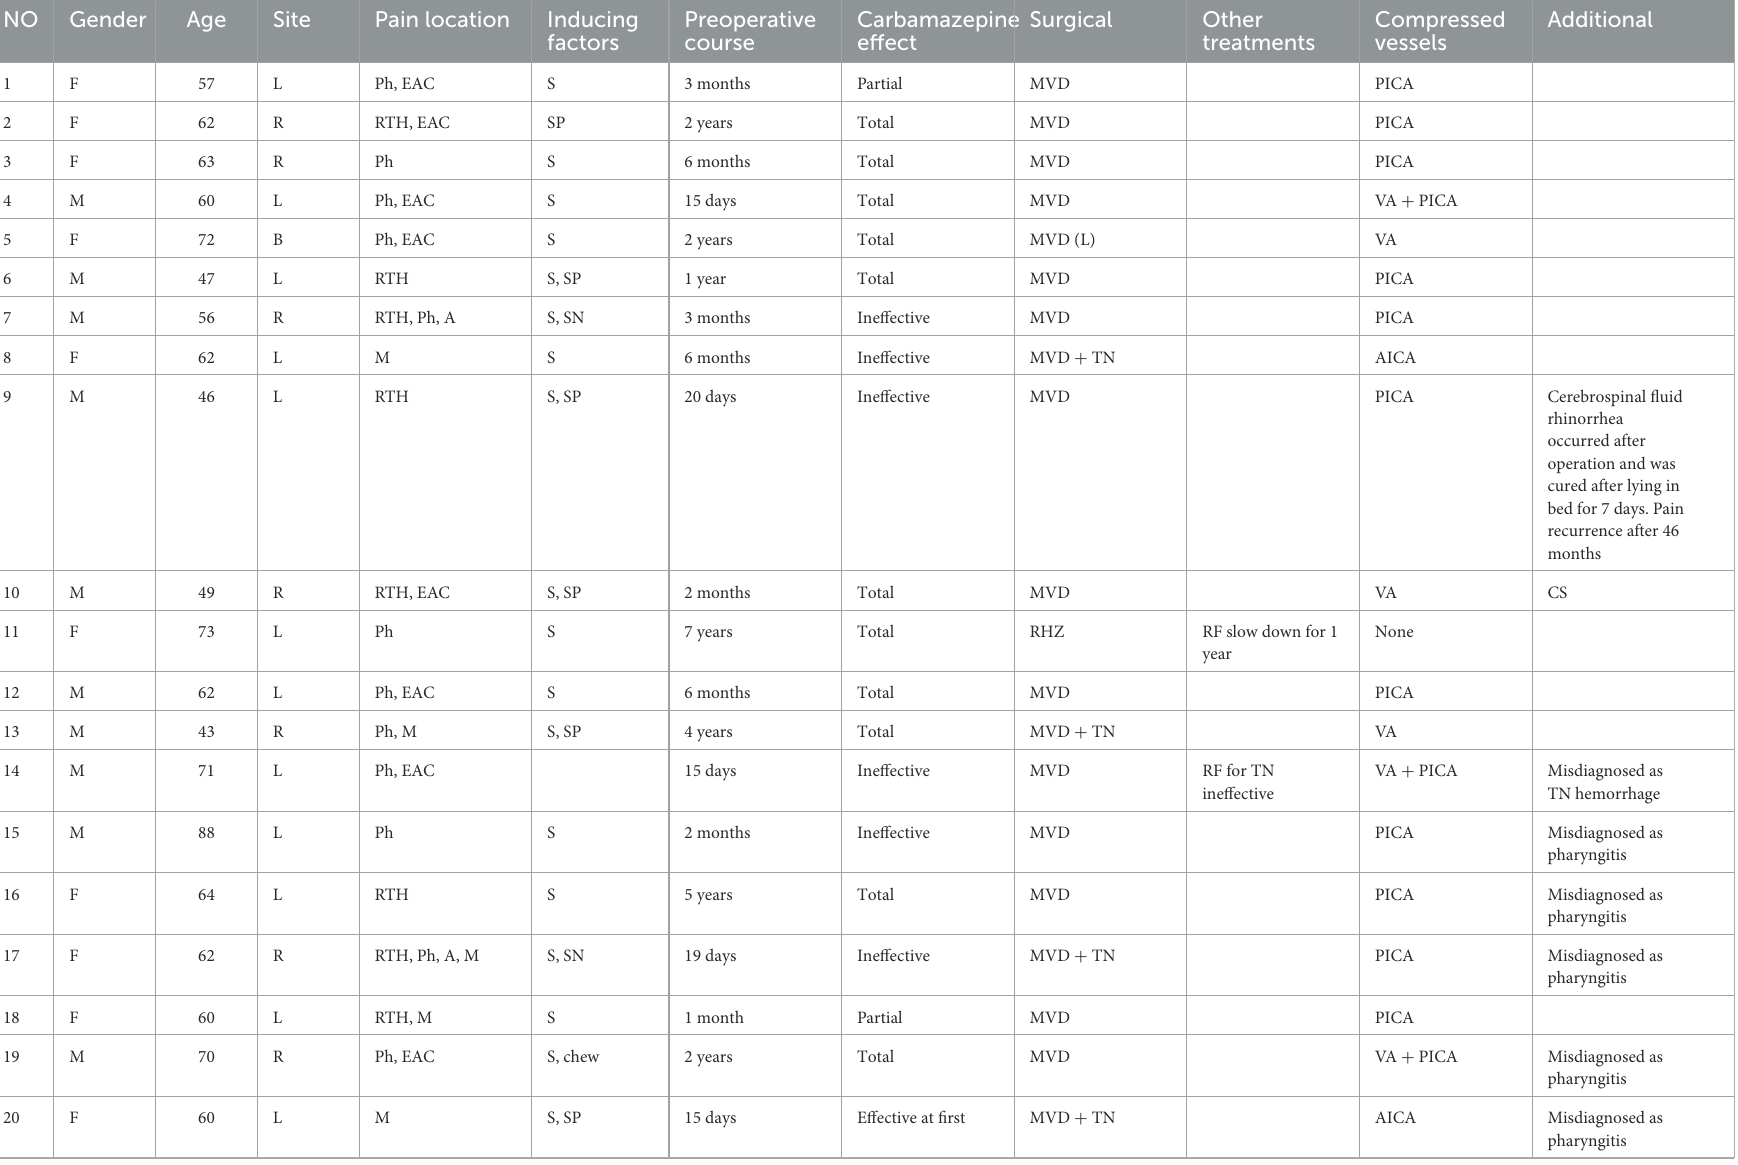
TABLE 1 Information of 63